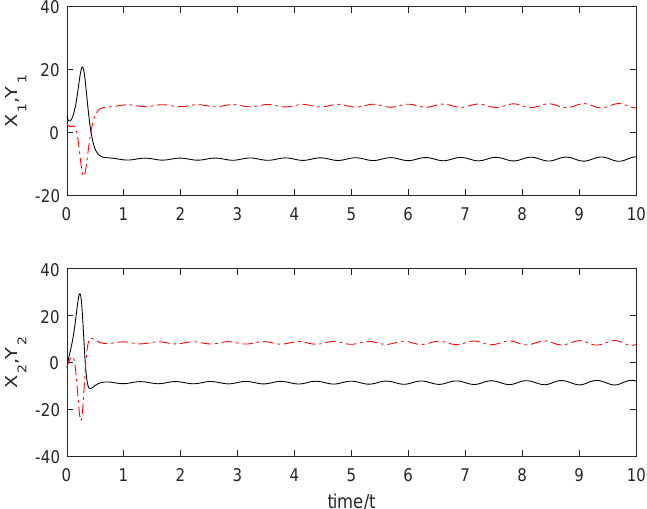
Figure 3. The states of the master subsystem (32) and the slave subsystem (34). Example 2. Fractional-order hyper-Chen system